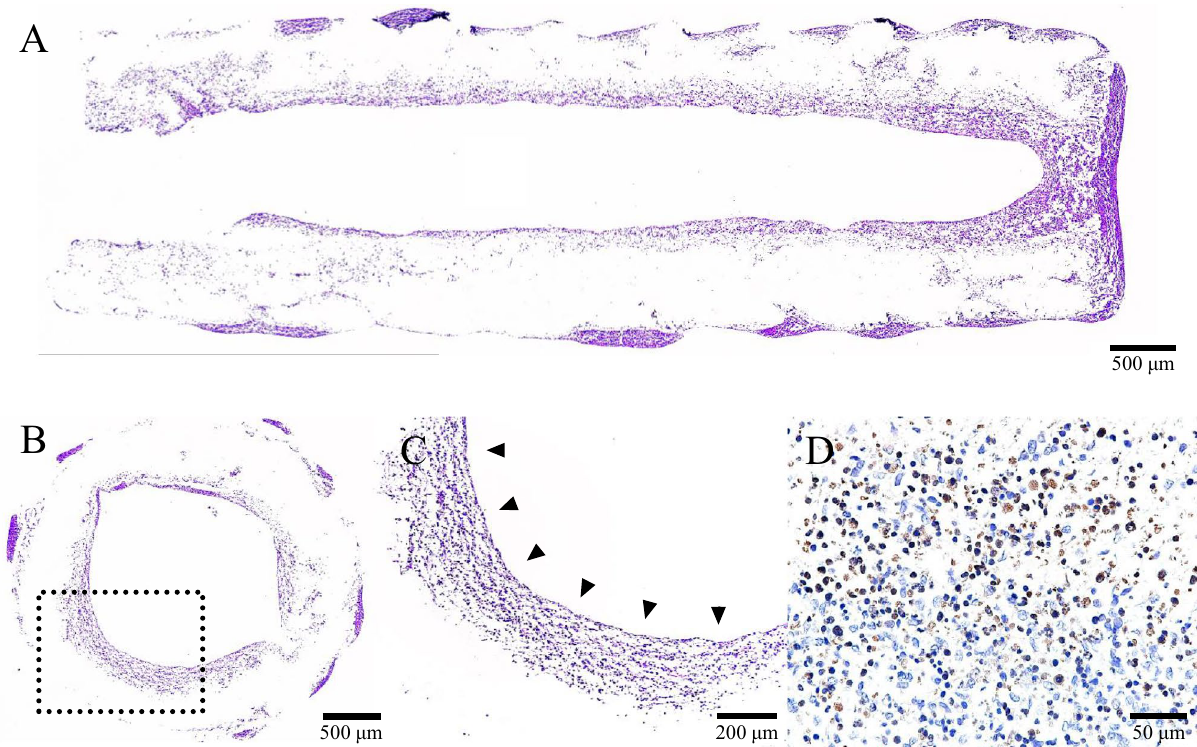
Figure 3. HE-stained images in a longitudinal ( A ) and transverse ( B and C ) sections of the central part of the nerve conduits after 14 days of coating with hiPSC-derived quaternary neurospheres prior to implantation. ( C ) A higher magnification of the region of inner porous sponge within the nerve conduit depicted in ( B ). The hiPSC-derived quaternary neurospheres have adhered to the inner surface of the nerve conduits (black triangles) and have migrated into the inner porous sponge. ( D ) Immunohistochemically stained image with anti-S-100